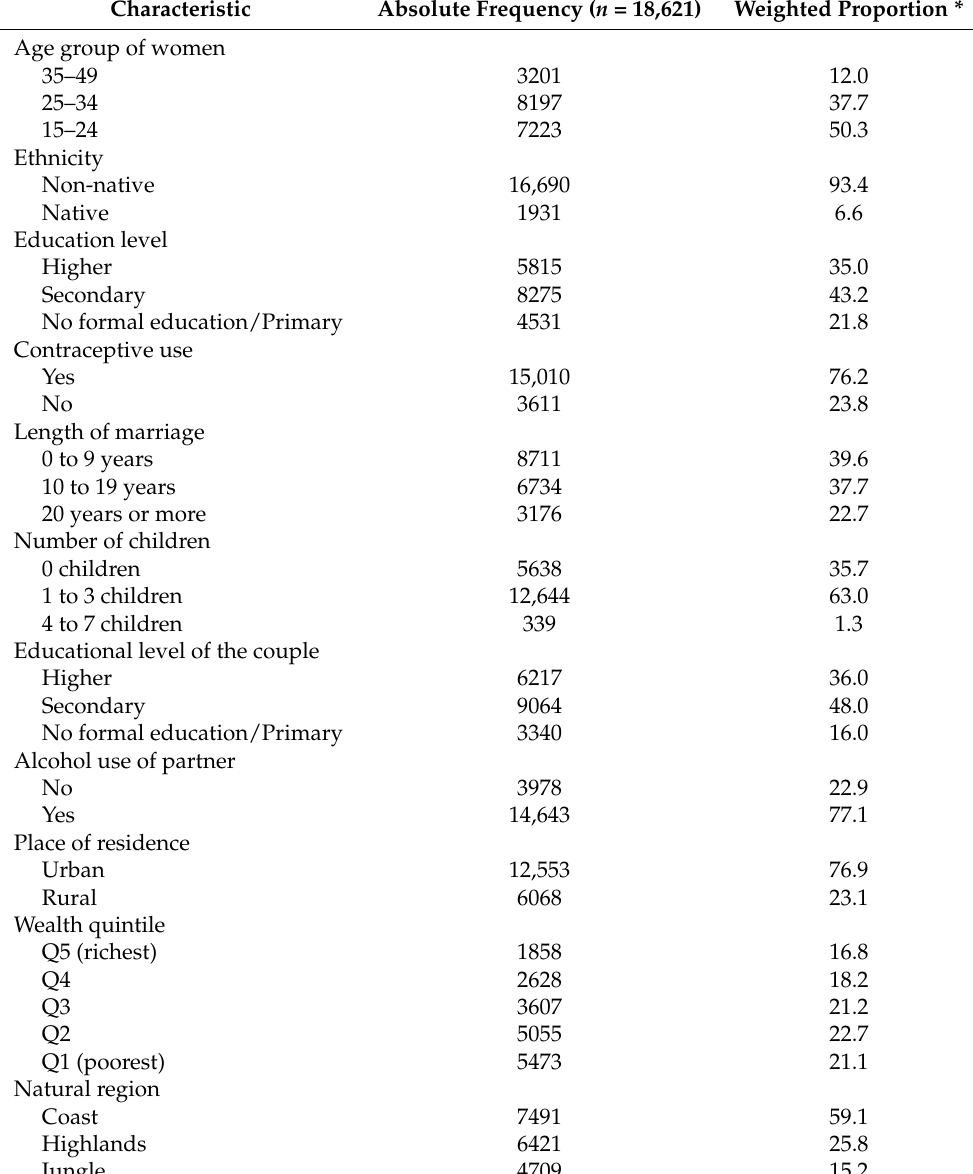
Table 2. Characteristics of Peruvian women aged 15 to 49 years included in the